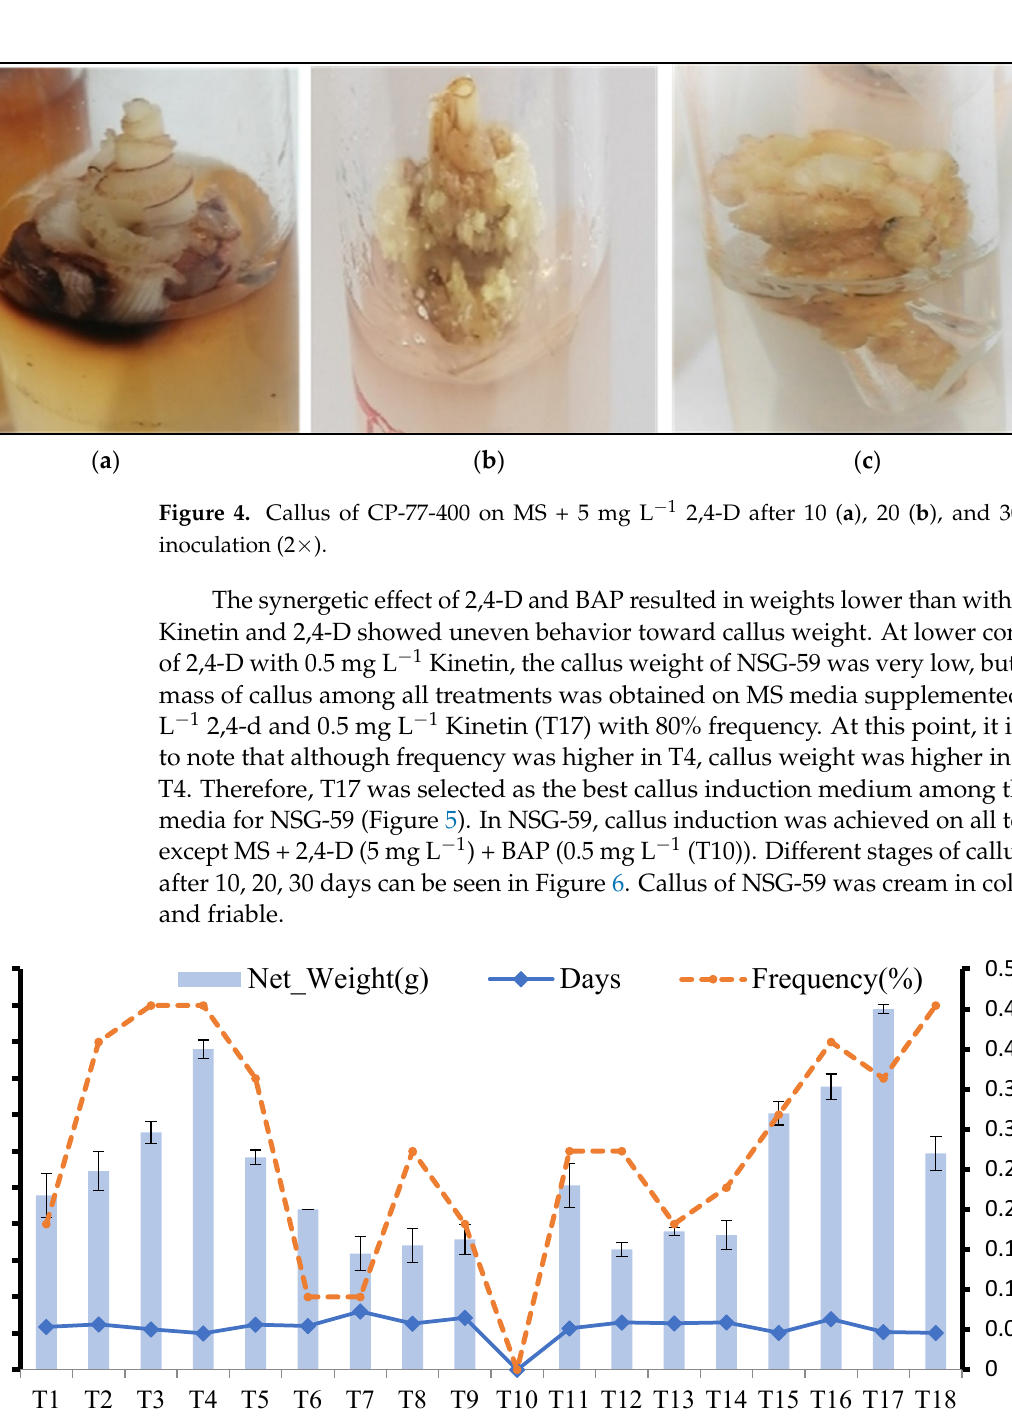
Figure 5. Effect of different media compositions on callus induction in terms of callus, number of days, and frequency in NSG-59.